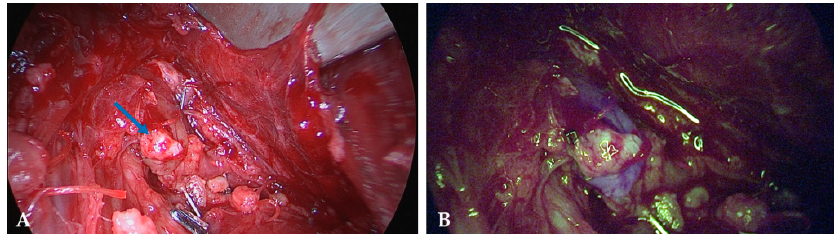
Figure 3. Image of an inferior parathyroid gland identified during central lymph node dissection and stuck to a lymph node (blue arrow) and extremely difficult to recognize when exposed to white light ( A ). In the NIR mode ( B ) the parathyroid tissue displays a well recognizable bluish violet color.